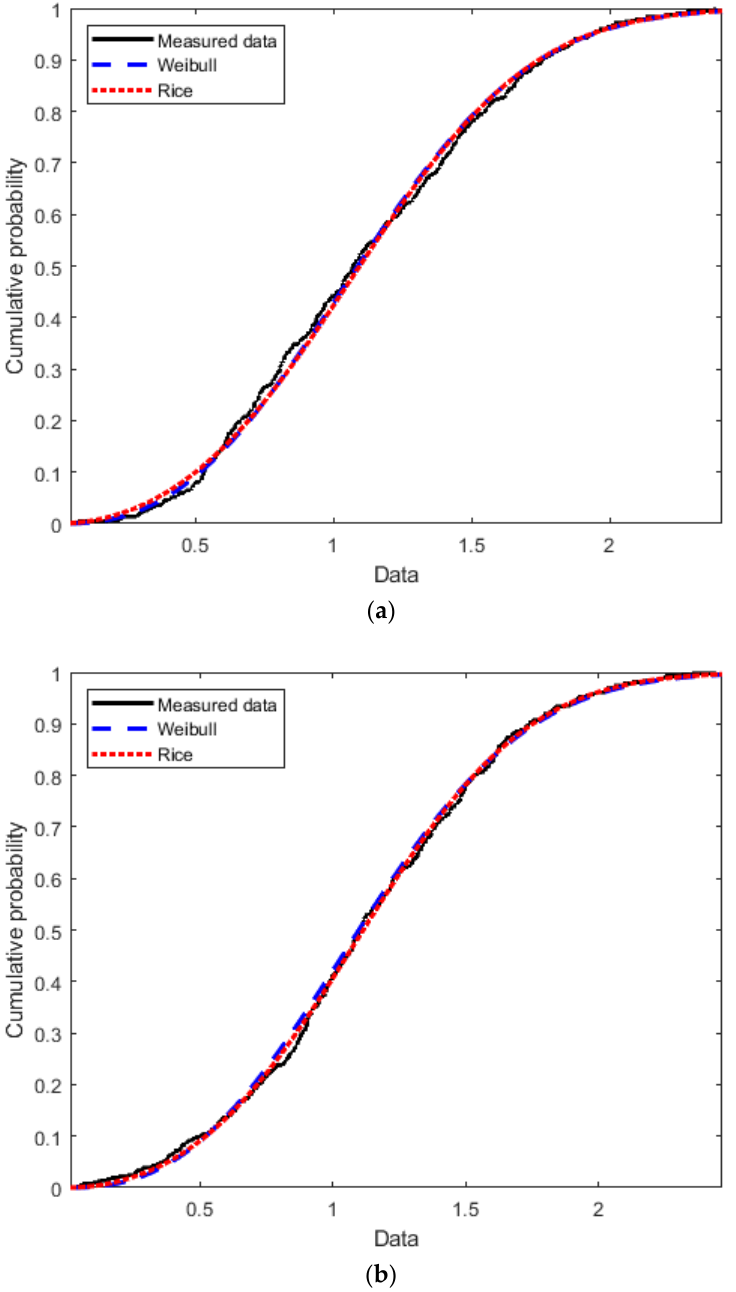
Figure 16. Cumulative distribution functions fitting fast variations within the office at 5.8 GHz. ( a ) Empty; and ( b ) furnished.